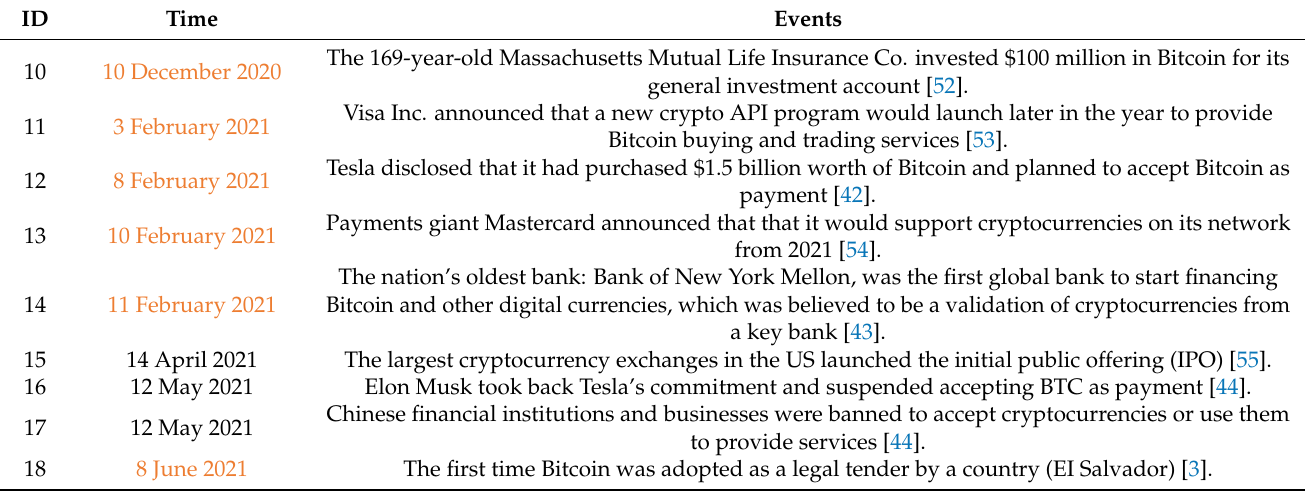
Figure 6 are normalized. The X-axis label N represents the number of data points t 2 − t 1 in each fitting window or the length of each fitting